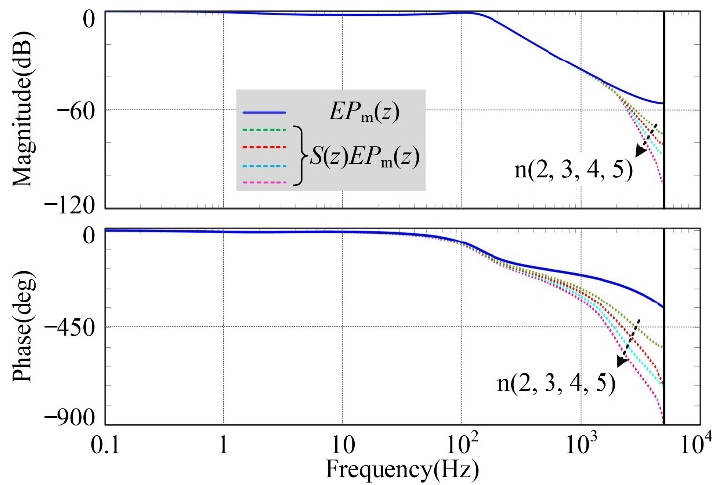
Figure 8. Frequency characteristics of the control plant with or without Butterworth filter.